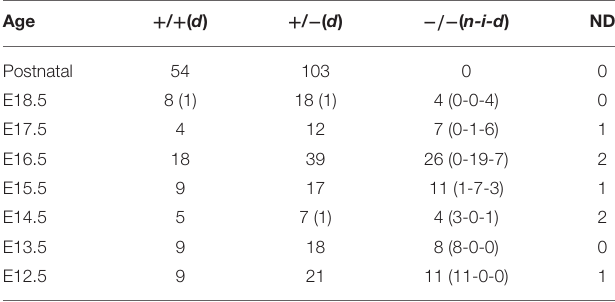
TABLE 1 | Genotype analysis of offspring from SNX17 + / −